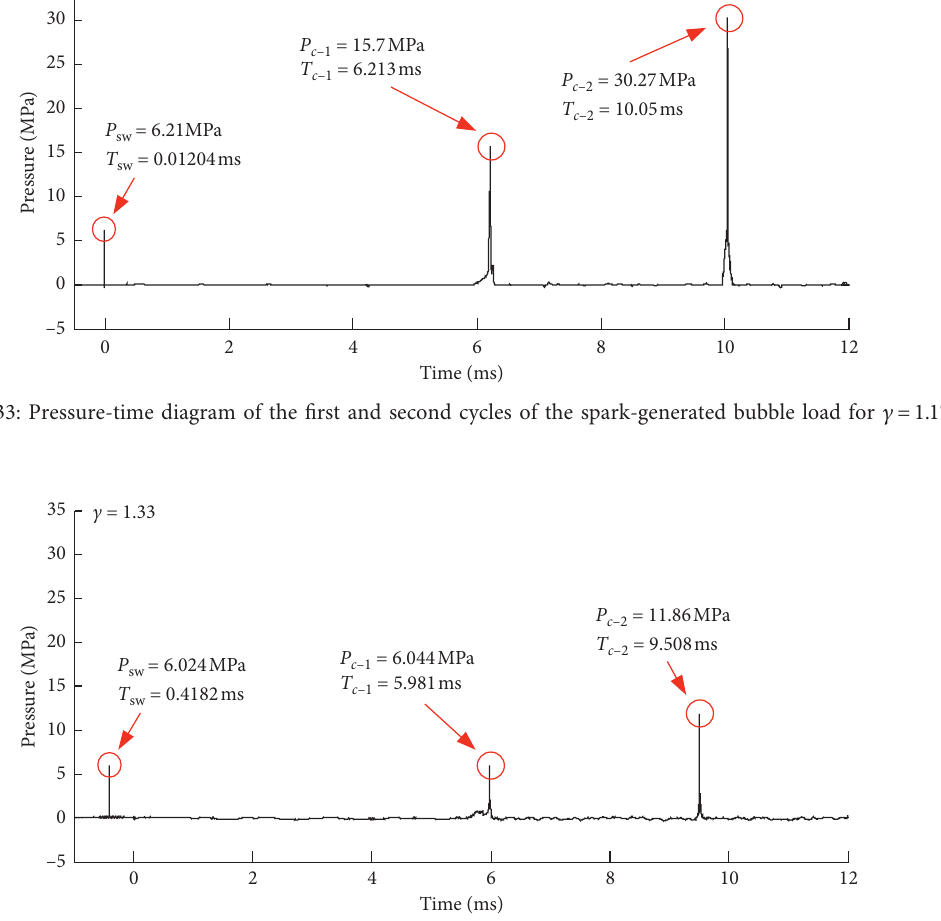
Figure 34: Pressure-time diagram of the first and second cycles of the spark-generated bubble load for c � 1.33.